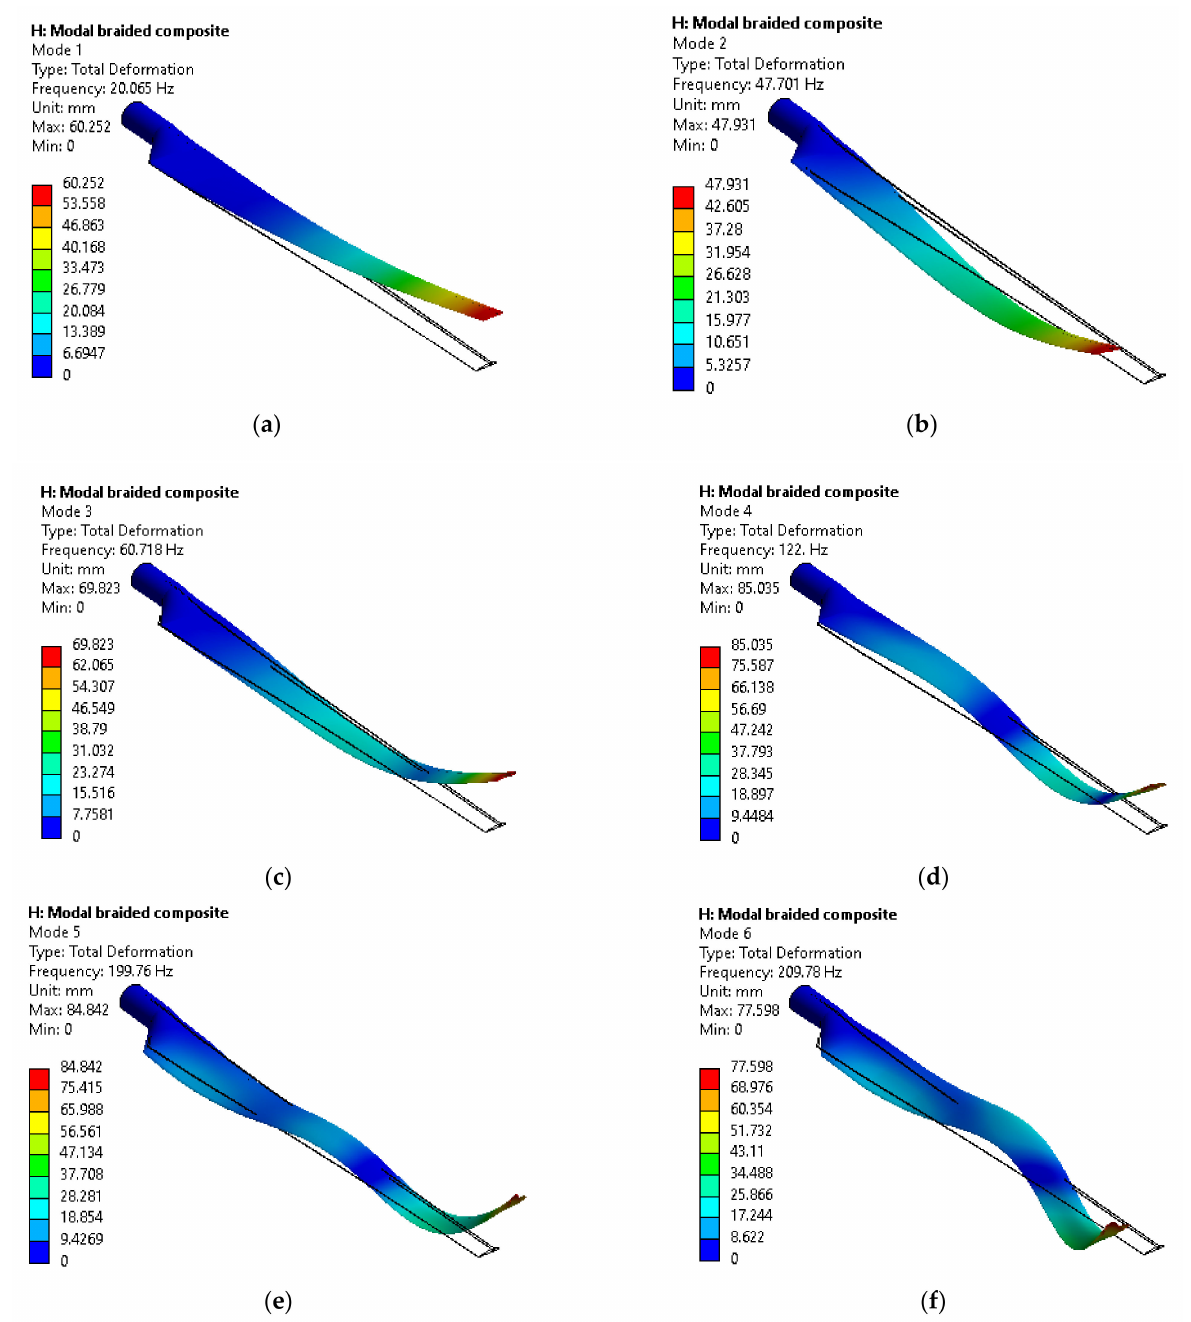
Figure 16. The first 6th mode shape of Braided composite material. ( a ) 1st mode. ( b ) 2nd mode. ( c ) 3rd mode. ( d ) 4th mode. ( e ) 5th mode. ( f ) 6th